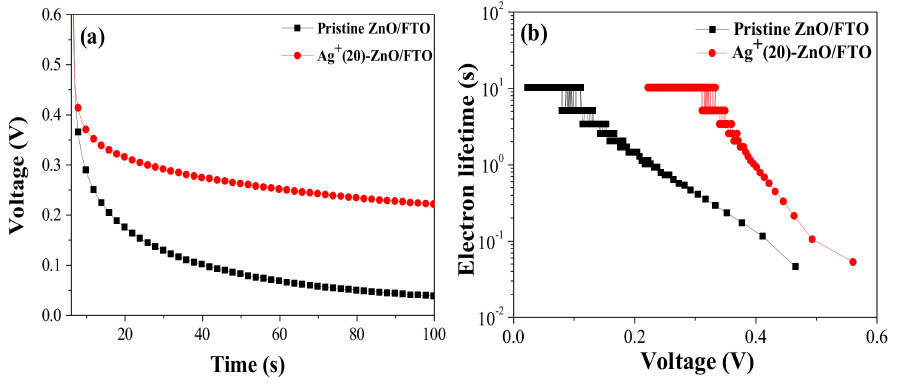
Figure 7. ( a ) OCVD Curves and ( b ) the electron lifetime versus the V oc for the DSCs with the pristine ZnO/FTO and Ag +